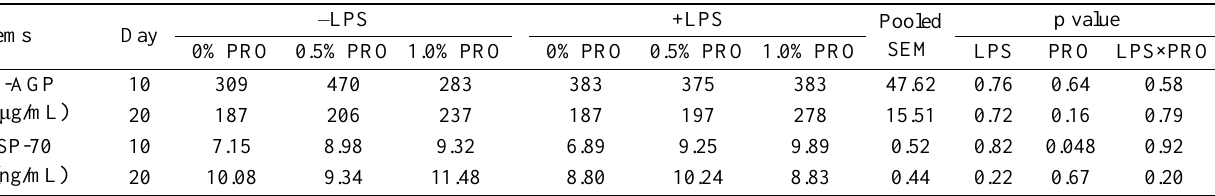
Table 6. Effects of L-proline supplementation on plasma α1-AGP, and HSP-70 concentration of weanling piglets after LPS challenge